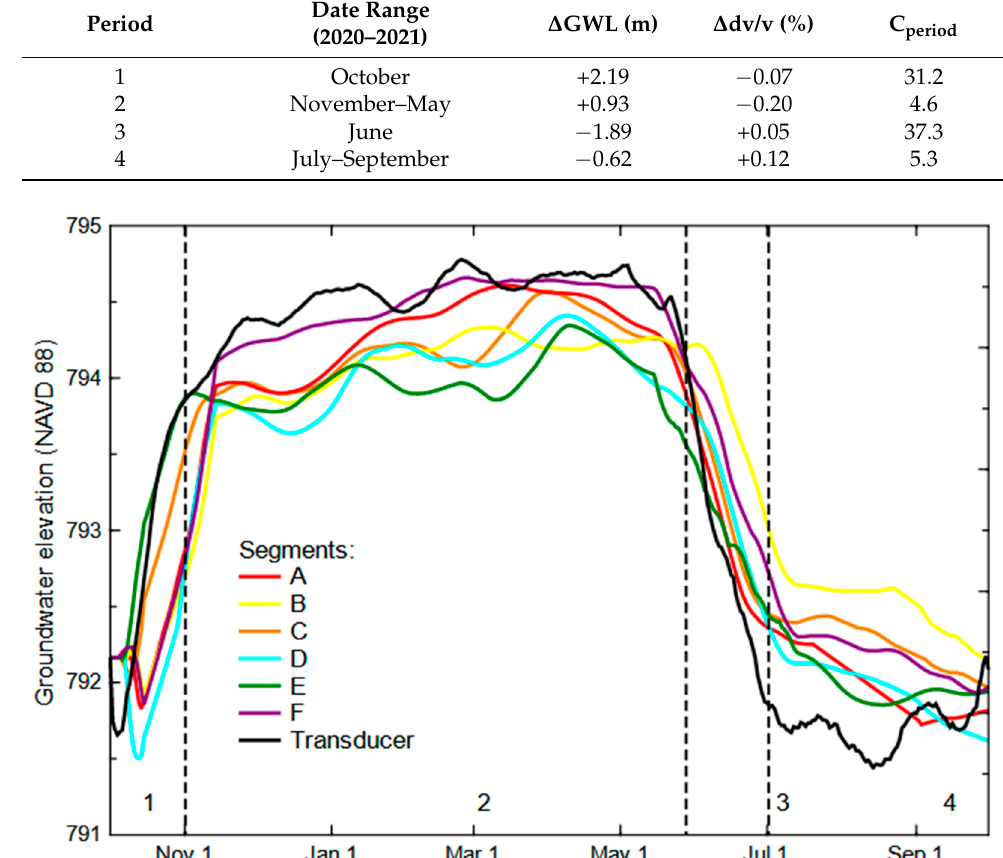
Table 3. Seasonal periods and associated changes in groundwater ( ∆ GWL) and seismic wave velocity ( ∆ dv/v) for correlating (C period ) the data sets and estimating groundwater levels. Period